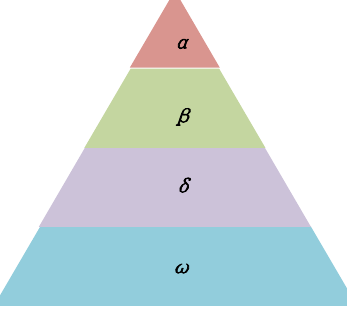
Figure 9. The hierarchy of the gray wolf population.